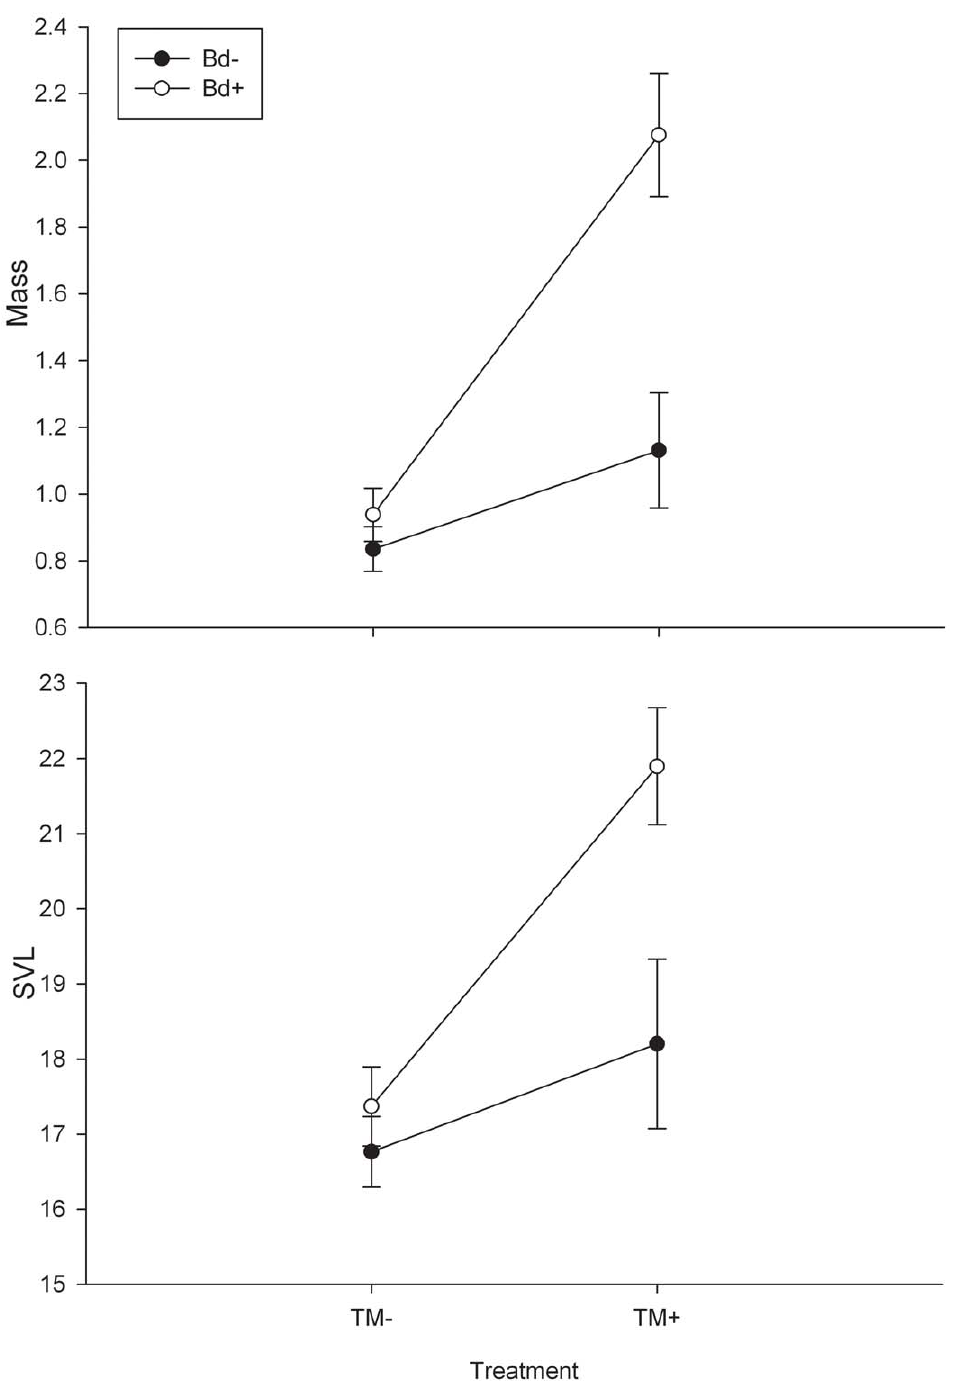
Figure 1. The effects of Bd and TM on larval mass and SVL at day 60. Asterisks (*) above plots indicate significant differences from TM 2 treatments (P , 0.05). *indicates significant difference from TM 2 treatments while **indicates significant difference from TM 2 and Bd 2 TM + treatments.